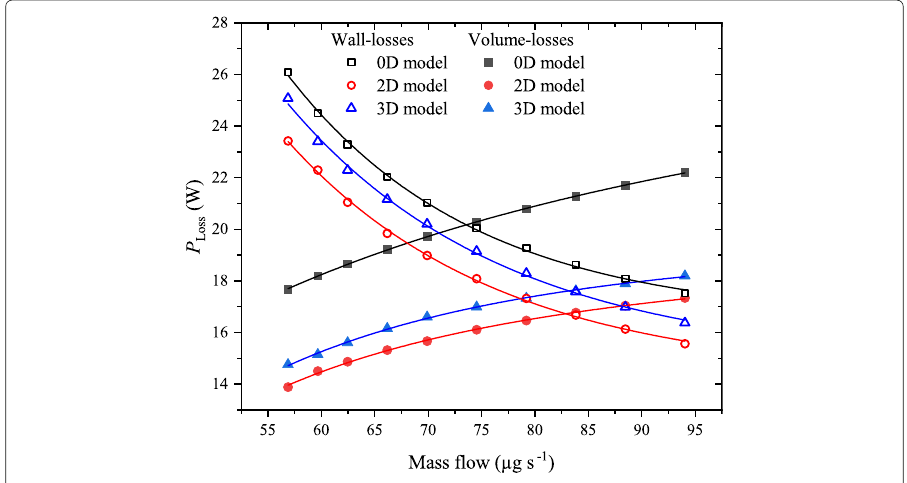
Fig. 11 Power deposited in two major groups of loss channels, losses on the thruster’s walls and those inside the plasma volume, as function of the mass flow injected in the discharge vessel, as calculated by the three global models. The open symbols represent the losses of walls, while the full symbols represent the losses inside the plasmas